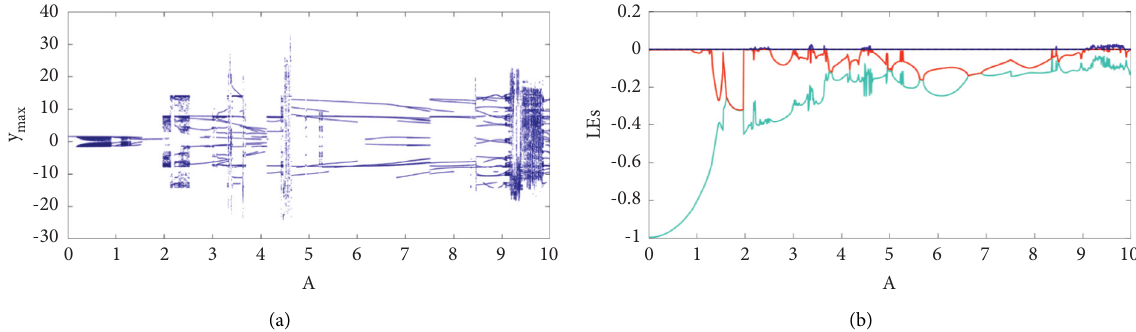
Figure 2: (a) Local maximum values of “ y ” time-series versus A in System (2) when ω � 0 . 6. The initial conditions are ( 0 . 1 , 0 ) without reinitiating. Thus, the diagram is only related to the first (inner) limit cycle around the origin. (b) Corresponding Lyapunov exponent diagram. The dynamic of the system starts from an attracting torus, then limit cycles observed, and finally strange attractors